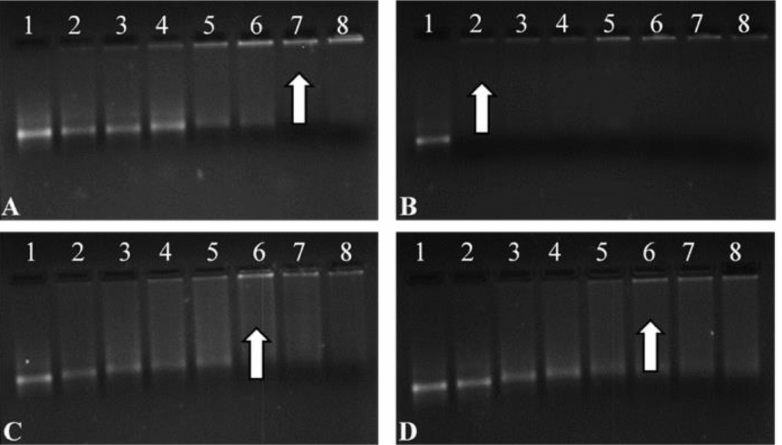
Figure 5. Band shift assay of the F luc -mRNA nanocomplexes with ( A ) CS-SeNPs, ( B ) LA-CS-SeNPs, ( C ) PEG-CS-SeNPs, and ( D ) LA-PEG-CS-SeNPs, using a 2% agarose gel. Arrows indicate optimal binding ratios. Lane 1: Control (naked mRNA (0.3 µ g/ µ L)). Lanes 2–8 ( A ) mRNA:CS-SeNP w /